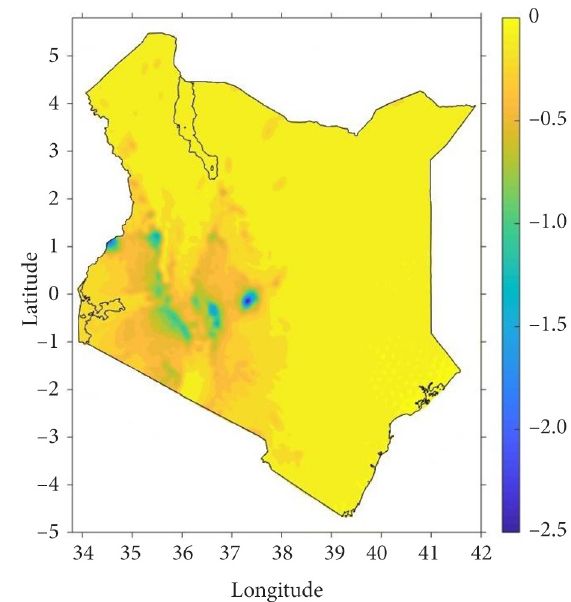
Figure 7. Spatial distribution of the corrections to height anomalies (to obtain geoid undulations) over Kenya (units are in m)